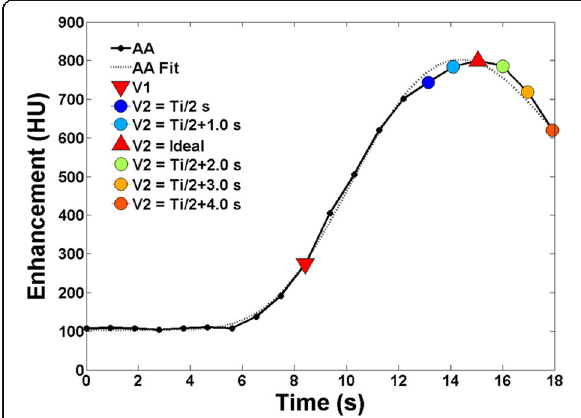
Fig. 4 Low-dose FPA perfusion protocol simulation. The aortic gamma variate fit was used to simulate dynamic bolus tracking-based triggering, where V1 was systematically selected as the first electrocardiographically gated volume scan after triggering, while V2 was systematically selected as the first electrocardiographically gated volume scan occurring T i to 4.0s after V1. The cardiac cycle distance of V2 from the ideal peak enhancement (red triangle) was then recorded. Note that the V2 volume scan also corresponds to the site of optimal CT angiography